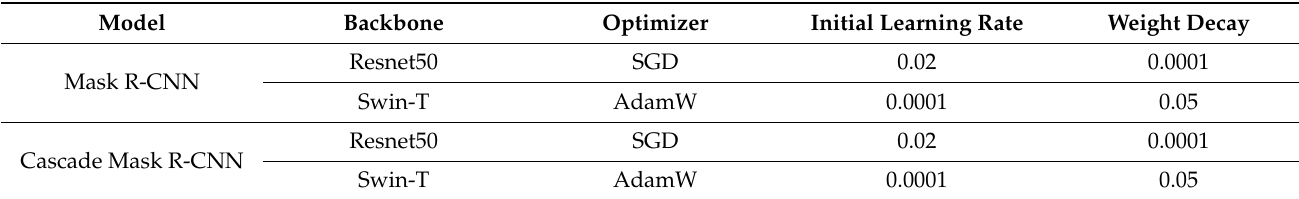
Table 1. Other parameters of each